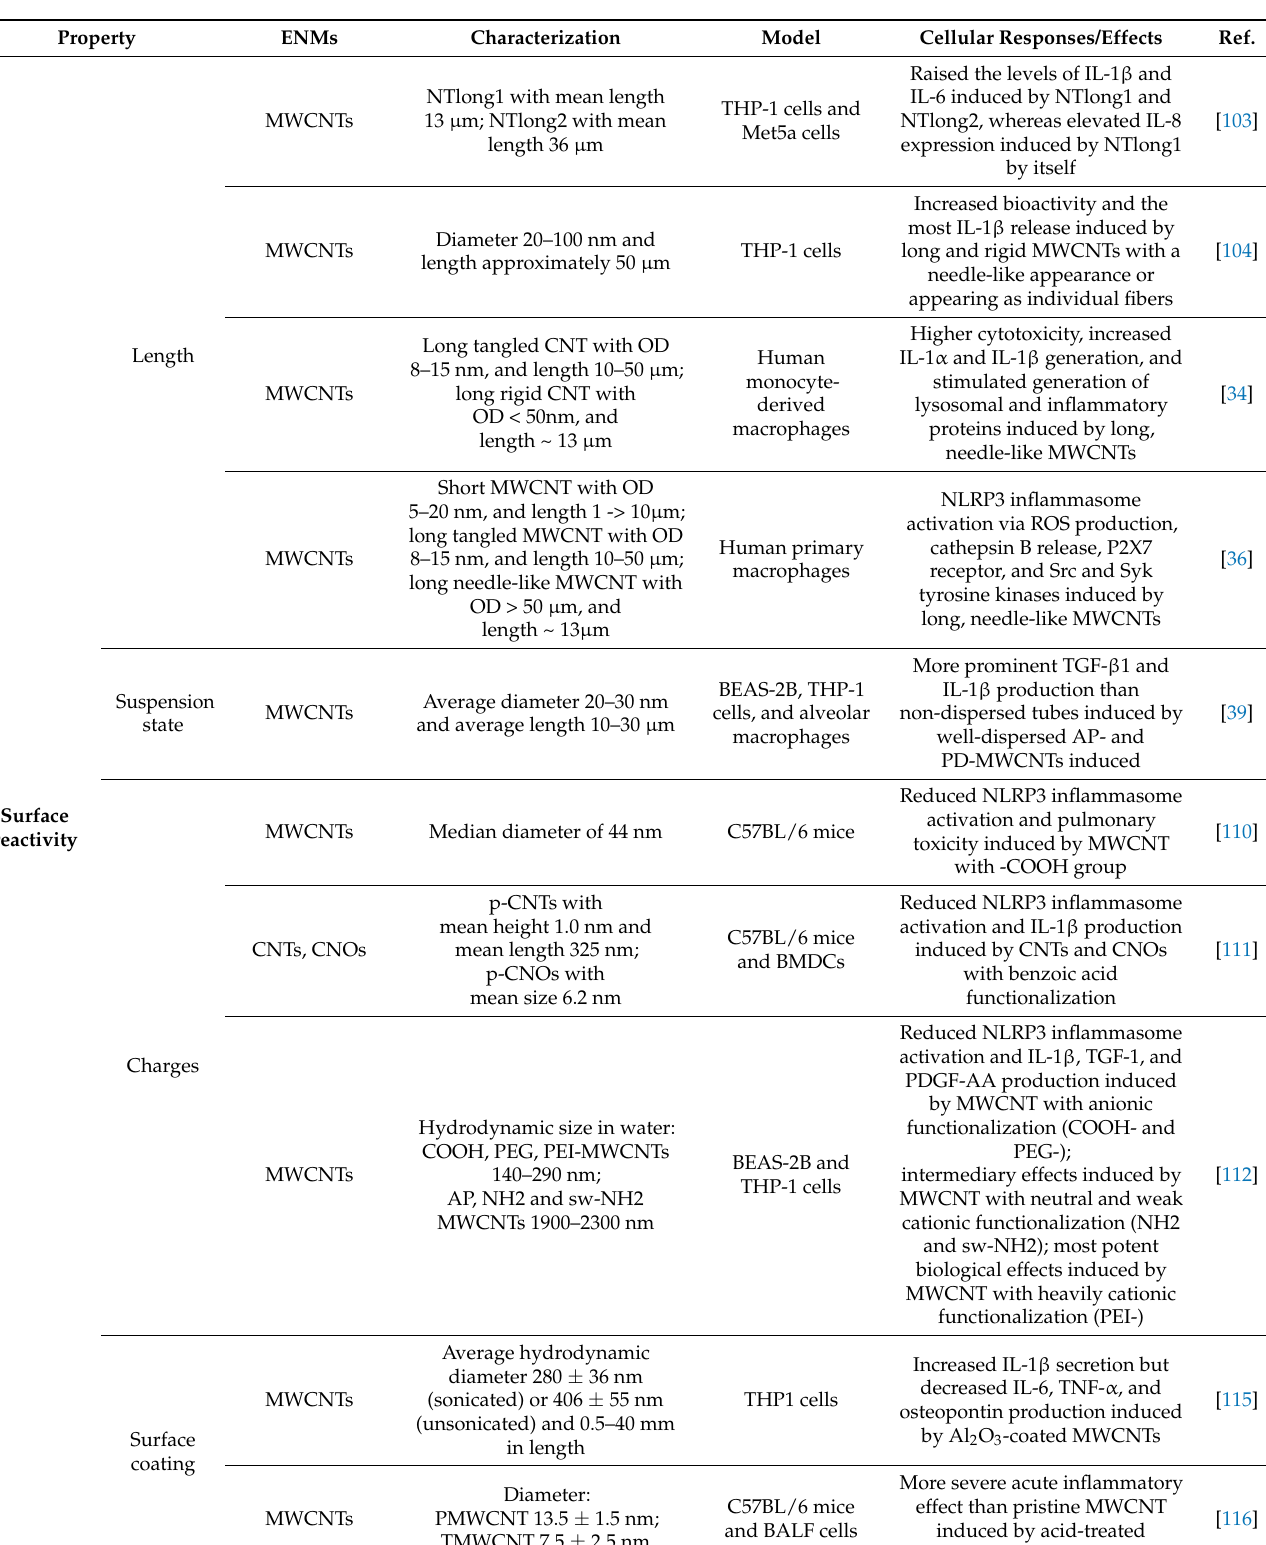
Table 2. Property activity relationships for